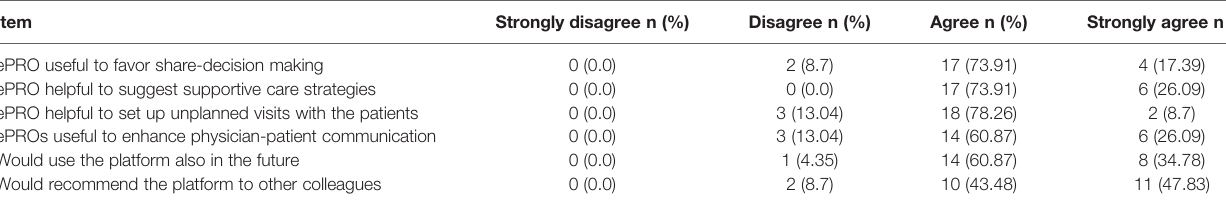
PRO, patient-reported